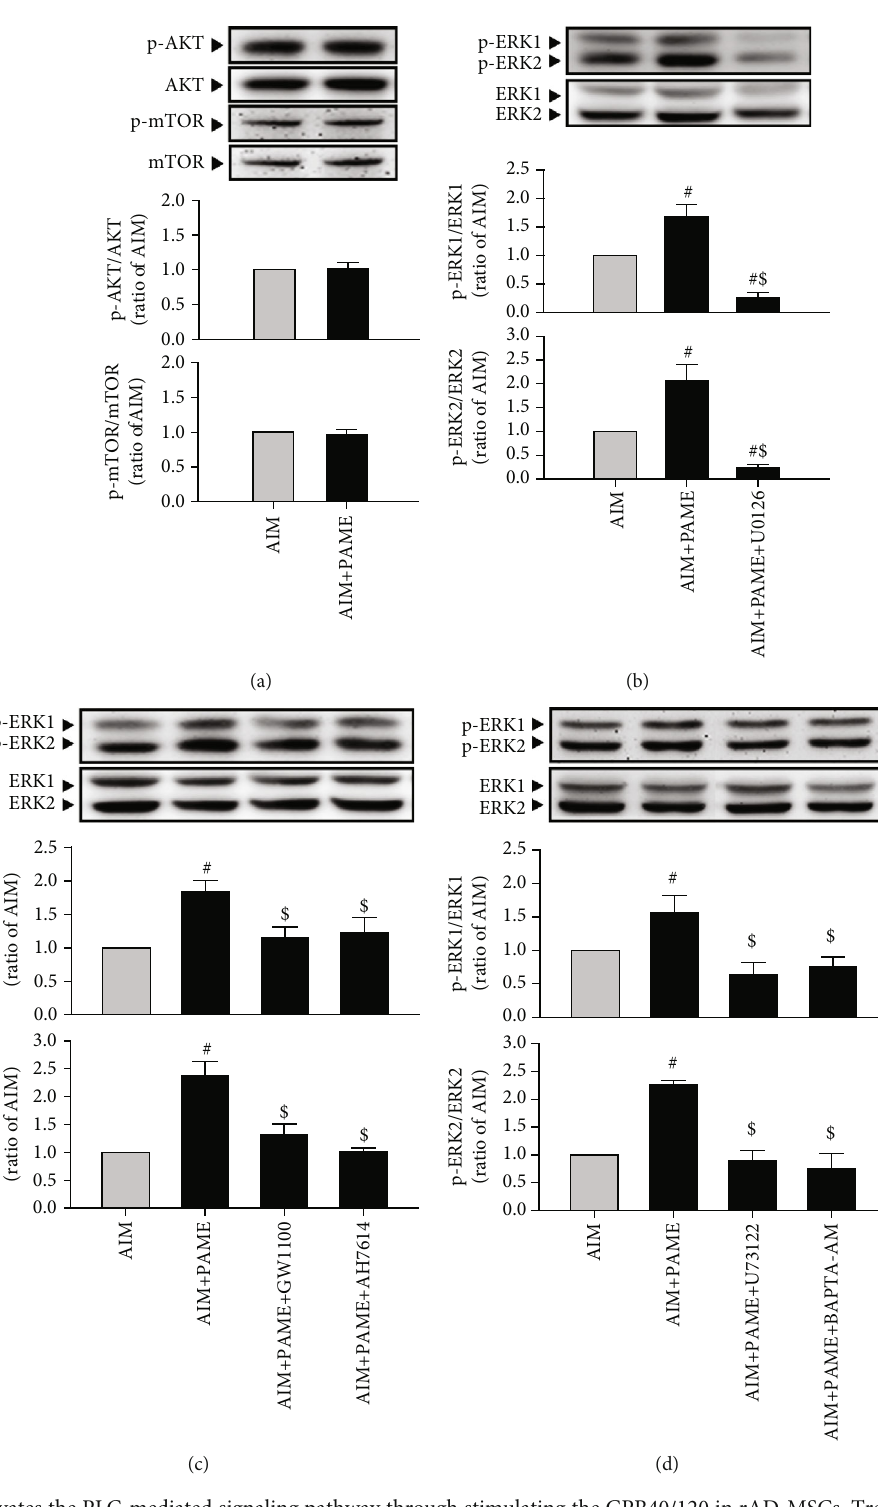
Figure 3: PAME activates the PLC-mediated signaling pathway through stimulating the GPR40/120 in rAD-MSCs. Treatment with PAME (50 μ M) in adipogenic induction medium for 12 days did not activate AKT and mTOR (a) ( n = 12 ) but induced ERK1/2 activation (b) ( n = 6 ). The PAME-induced ERK1/2 activation was abolished by cotreatment with ERK1/2 inhibitor (U0126). PAME (50 μ M) increased the levels of p-ERK1/2, and these e ff ects were abolished by cotreatment with GW1100, AH7614 (c) ( n = 4 ), U73122, or BAPTA-AM (d) ( n = 4 ). All data represent mean ± SEM . # p < 0 : 05 , versus the AIM group; $ p < 0 : 05 , versus the AIM+PAME group. AIM: adipogenic induction